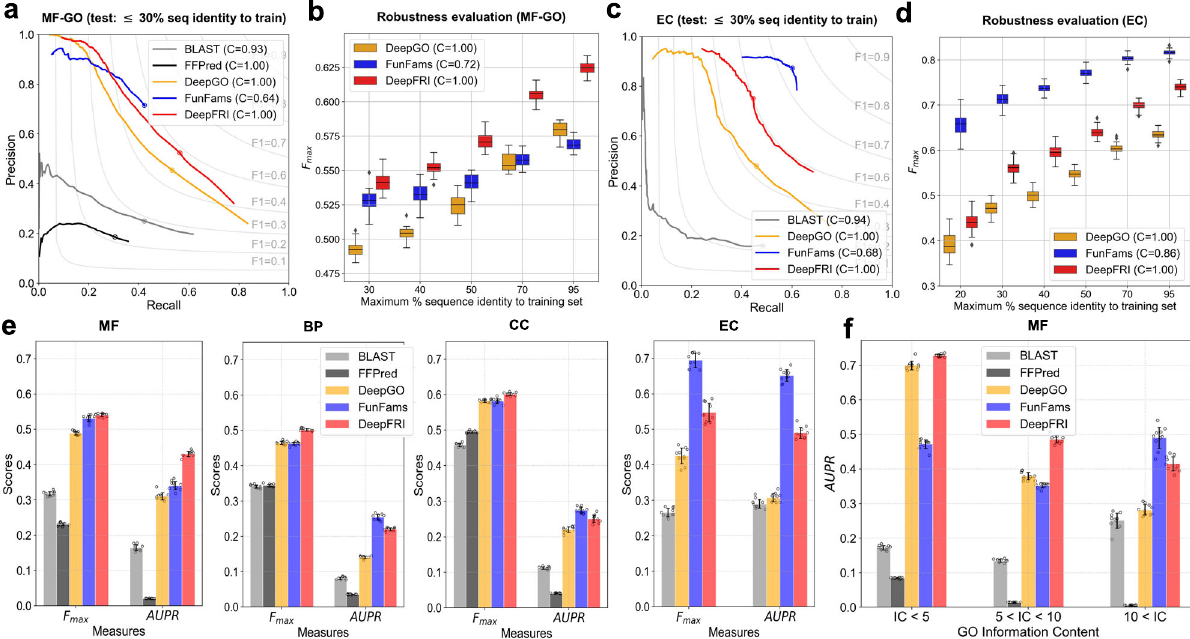
Fig. 3 Performance over GO terms in different ontologies and EC numbers. Precision-recall curves showing the performance of different methods on ( a ) MF-GO terms and ( c ) EC numbers on the test set comprised of PDB chains chosen to have ≤ 30% sequence identity to the chains in the training set. Coverage of the methods is shown in the legend. Distribution of the F max score under 100 bootstrap iterations for the top three best-performing methods applied on ( b ) MF-GO terms and ( c ) EC numbers computed on the test PDB chains and grouped by maximum % sequence identity to the training set. e Distribution of protein-centric F max score and function-centric AUPR score under 10 bootstrap iterations summarized over all test proteins and GO terms/EC numbers, respectively. f Distribution of AUPR score on MF-GO terms of different levels of speci fi cities under 10 bootstrap iterations. Every fi gure illustrates the performance of DeepFRI (red) in comparison to sequence-based annotation transfer from protein families, FunFams (blue), the CNN-based method DeepGO (orange), SVM-based method, FFPred (black), and BLAST baseline (gray). Error bars on the bar plots ( e and f ) represent standard deviation of the mean. In panels b and d , data are represented as boxplots with the center line representing the median, upper and lower edges of the boxes representing the interquartile range, and whiskers representing the data range (0.5 × interquartile